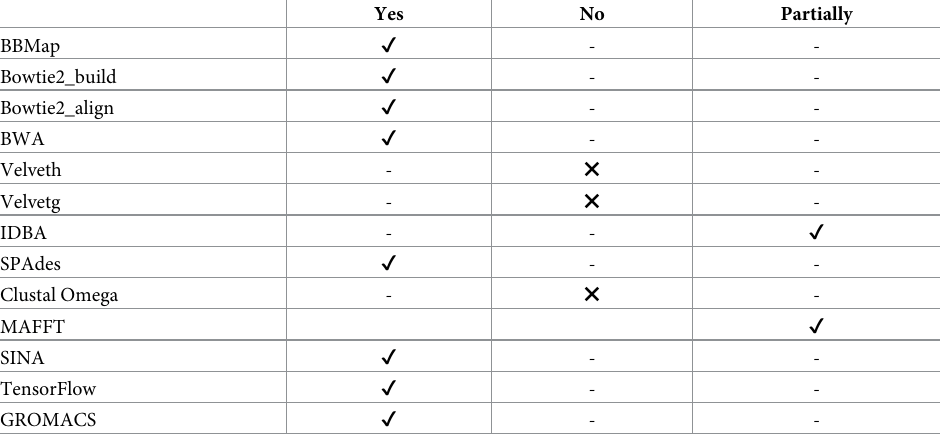
Table 7. Classification of the used applications by the scaling results into one of the three different categories Yes, No and Partially, related to the long dataset. The long dataset also represents the datasets short and middle. Category Yes means, that the application scales satisfactory with the number of used cores. Category No means it does not scale. Partially means, that for some numbers of CPU cores the application scales satisfactory for other not. Yes No Partially BBMap ✔ - - Bowtie2_build ✔ - - Bowtie2_align ✔ - - BWA ✔ - - Velveth - ✖ - Velvetg - ✖ - IDBA - - ✔ SPAdes ✔ - - Clustal Omega - ✖ - MAFFT ✔ SINA ✔ - - TensorFlow ✔ - - GROMACS ✔ -